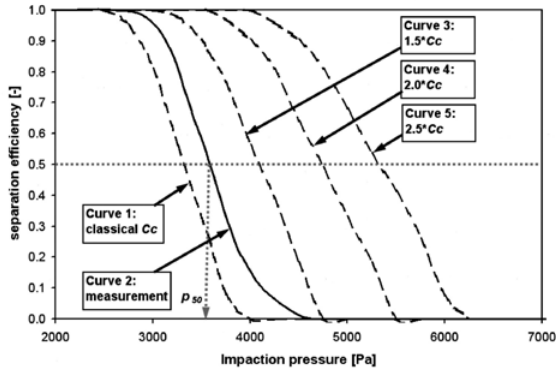
Fig. 7 Simulated (broken lines) and measured (solid line) separation curves of 521-nm DEHS droplets.